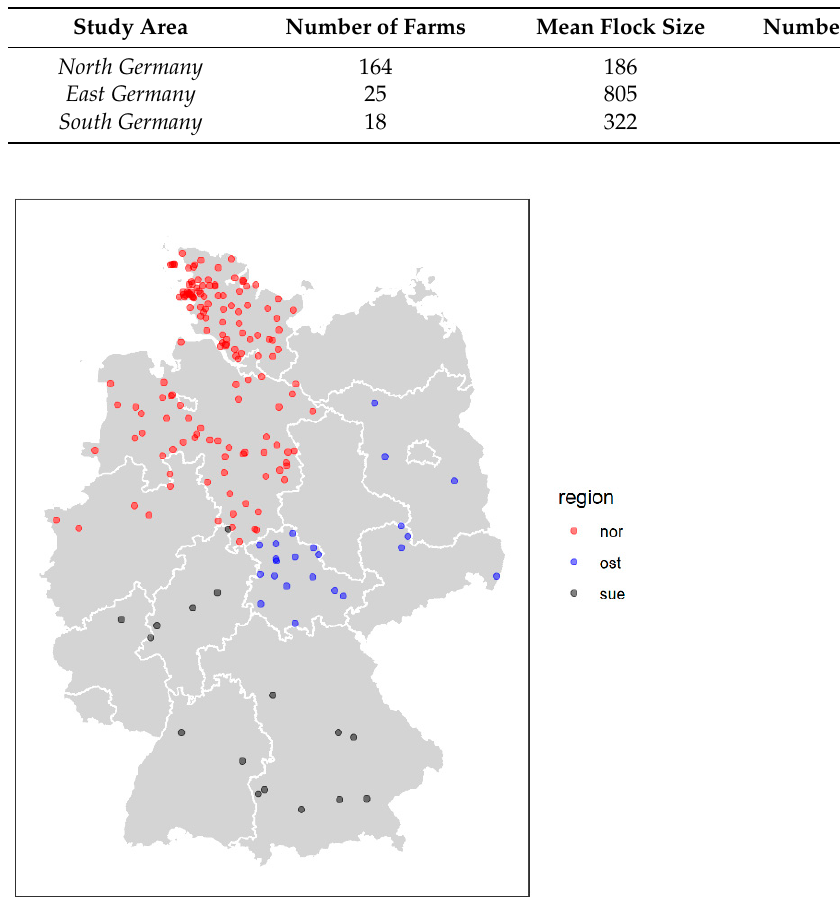
Figure 1. Geographical location of the 207 sheep farms sampled in Germany. Red: North Germany; blue: East Germany; black: South Germany.